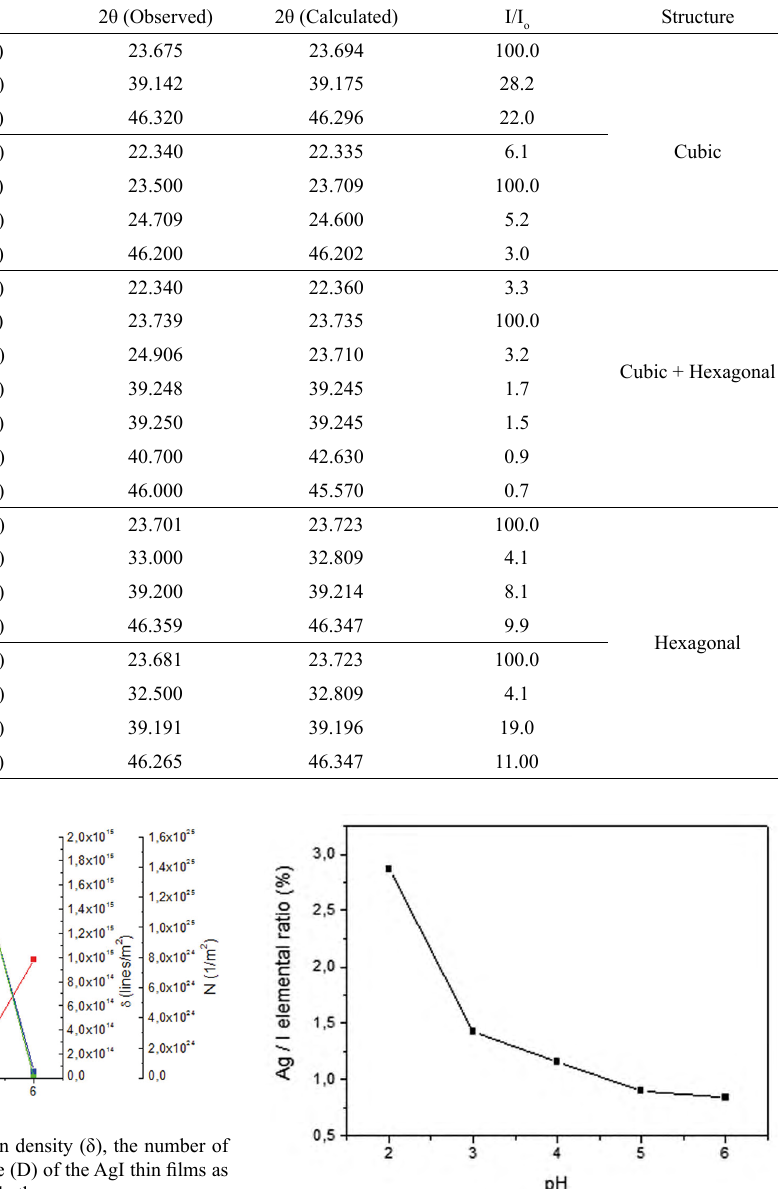
Figure 3. The ratio of Ag + and I - ions.